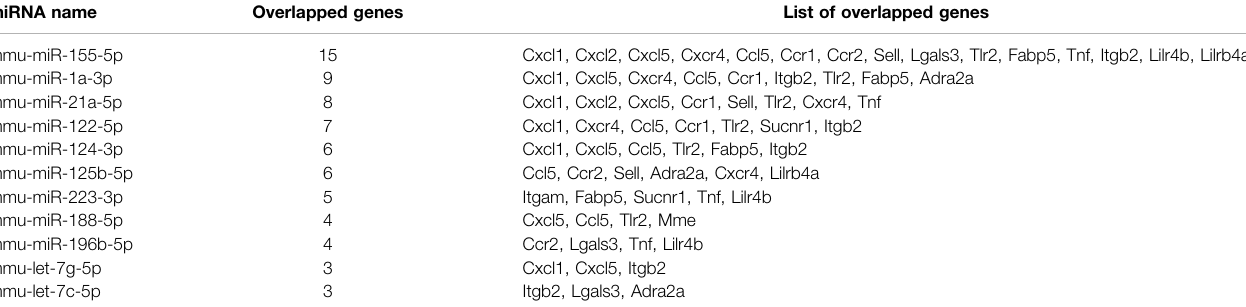
TABLE 2 | Prediction of the miRNAs of target genes via DIANA-TarBase.